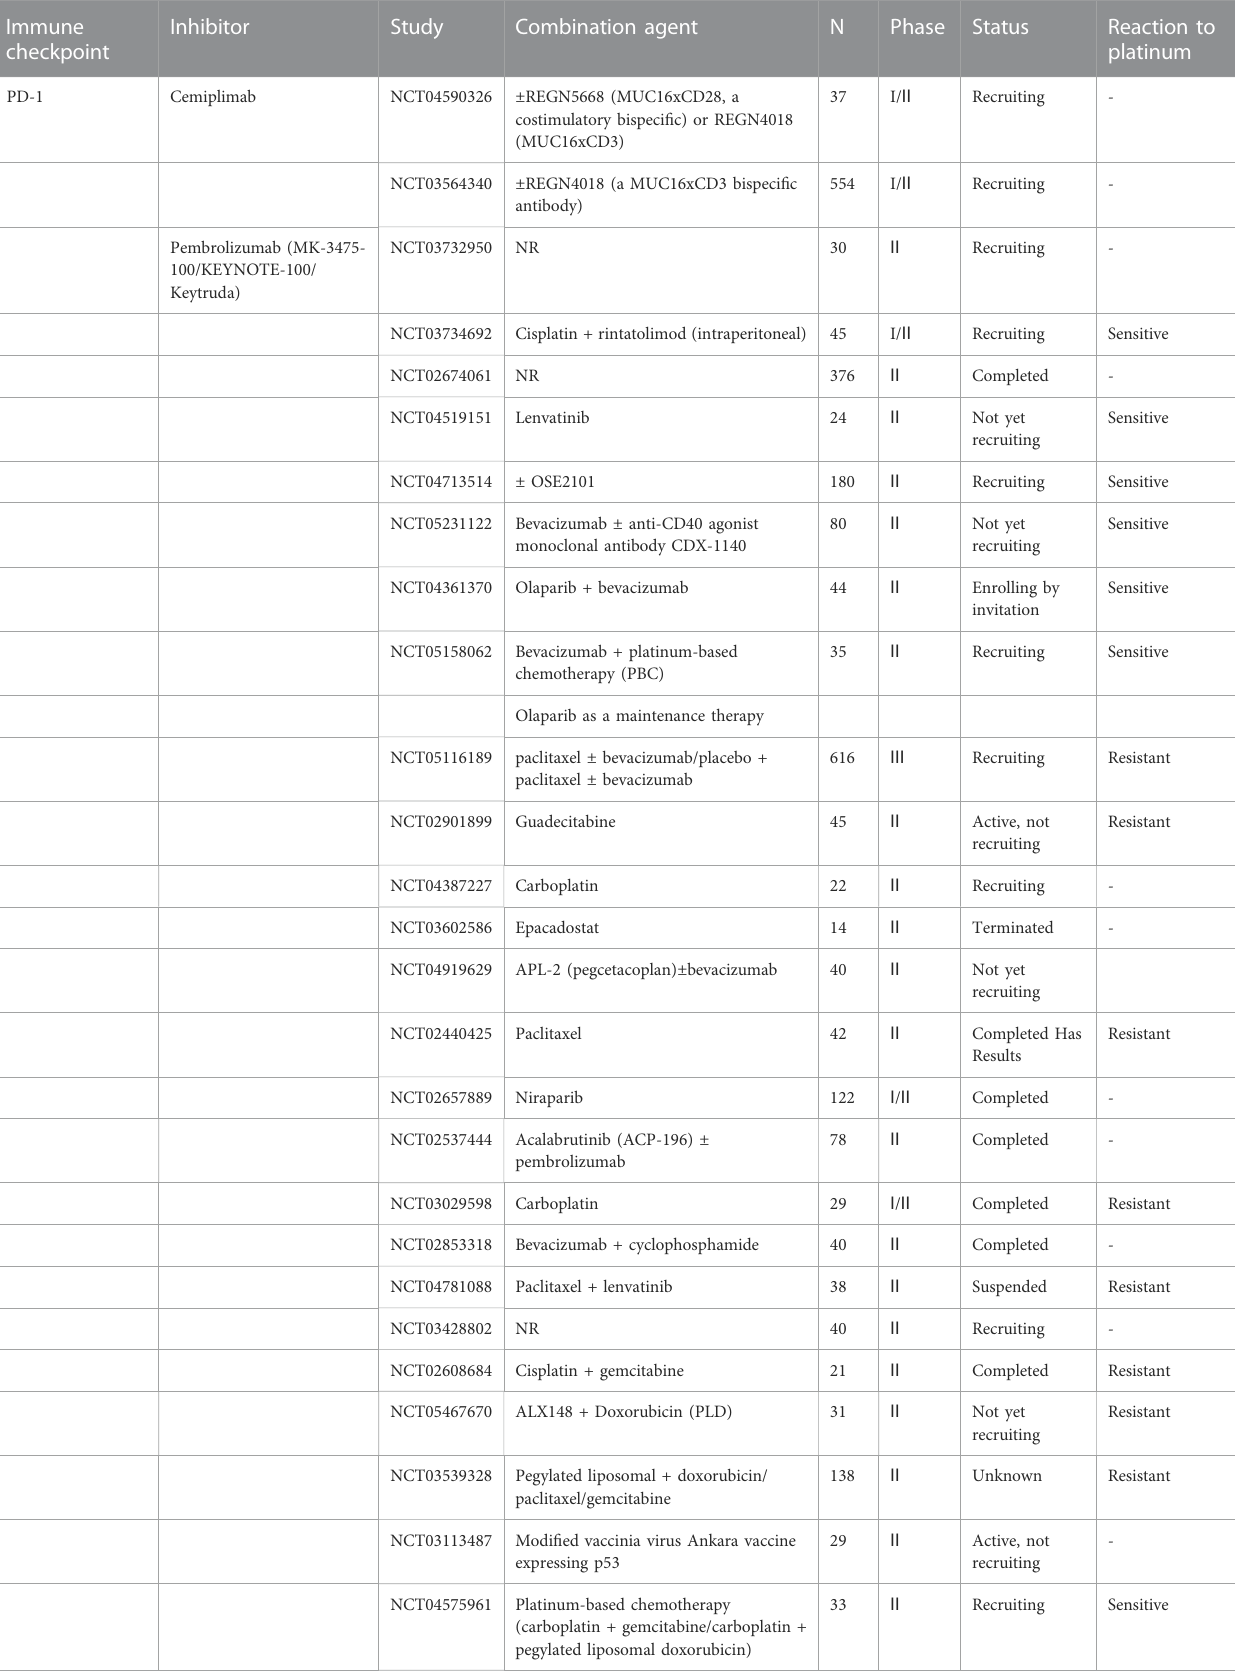
TABLE 3 Summary of all clinical trials of immune checkpoint inhibitors in the treatment of recurrent ovarian cancer published in Clinical Trials.gov. Immune